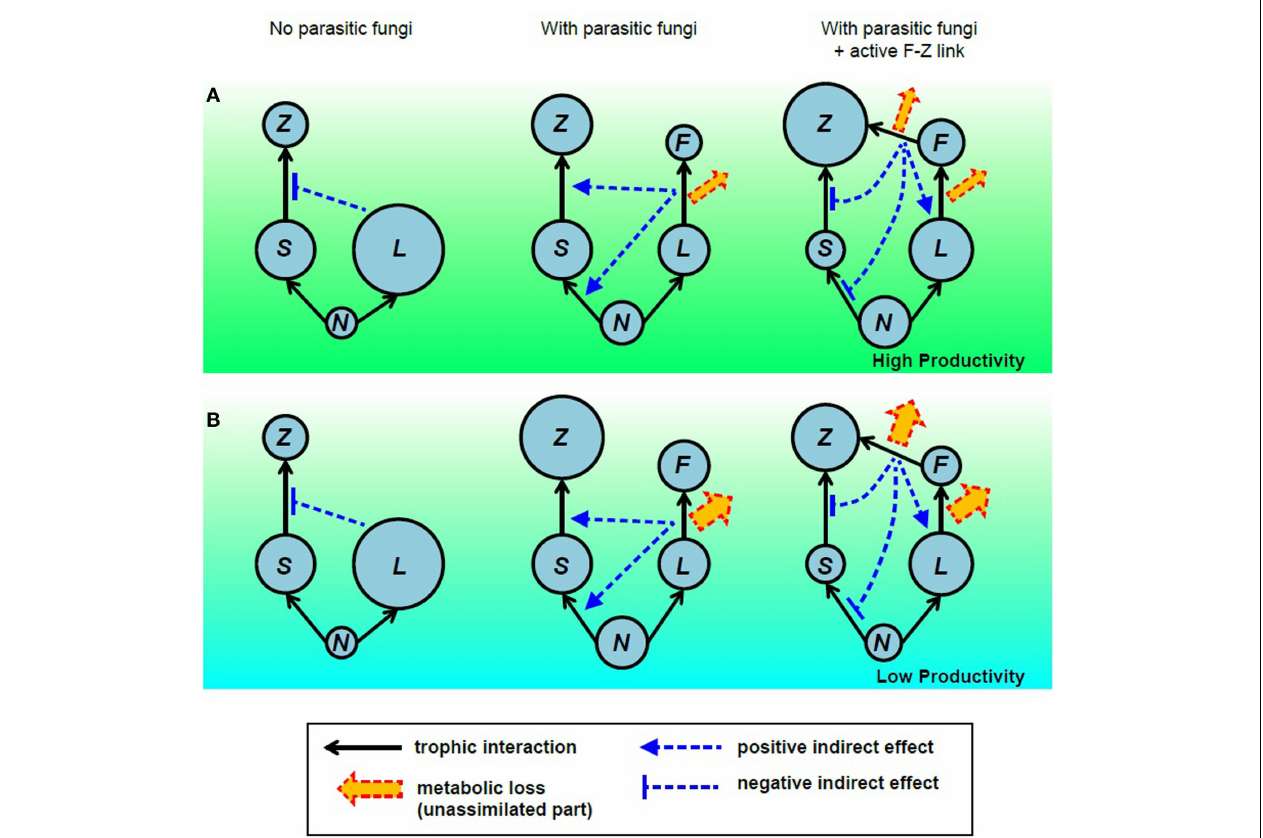
FIGURE 2 | Indirect effects of the F-Z link and their feedback on zooplankton. The net effects of the fungus–zooplankton link on zooplankton biomass production depends on three conditions: the growth efficiency of fungi on the host, the growth efficiency of zooplankton consuming fungi, and the nutrient supply in the system. N , inorganic nutrient; L , large phytoplankton; S , small phytoplankton; F , chytrid fungi; and Z , zooplankton. (A) When these growth efficiencies are high, in